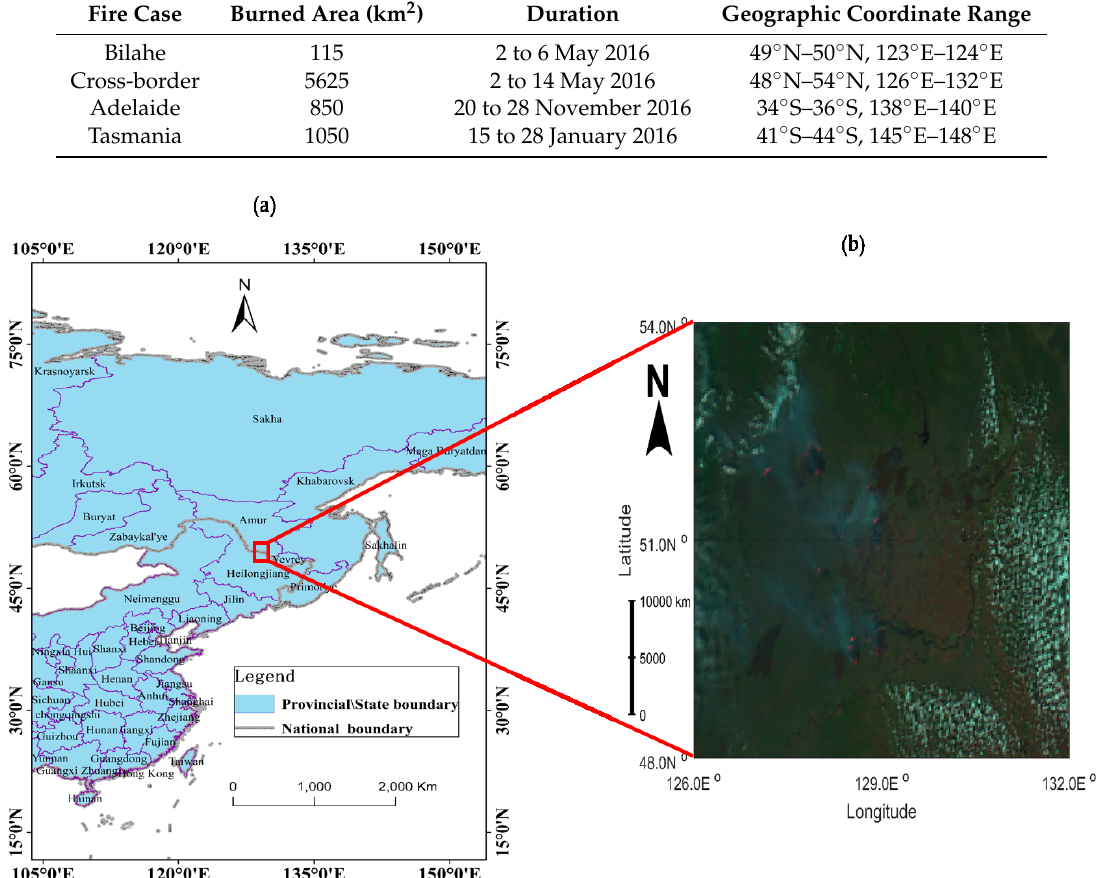
Table 1. Case study fires used for evaluation of the spatiotemporal contextual model (STCM) algorithm.